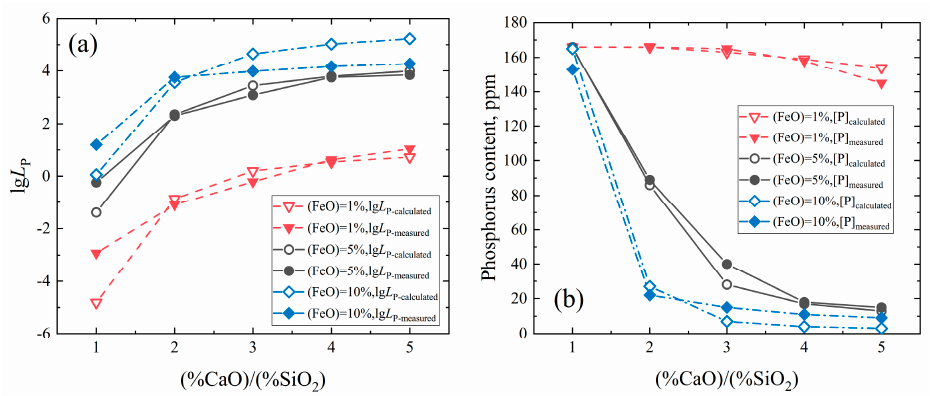
Figure 6. E ff ect of basicity (%CaO) / (%SiO 2 ) and FeO content on the phosphorus distribution ratio Figure 6. Effect of basicity (%CaO)/(%SiO 2 ) and FeO content on the phosphorus distribution ratio ( a ) ( a ) and phosphorus content ( b ) in pure iron. and phosphorus content ( b ) in pure iron.